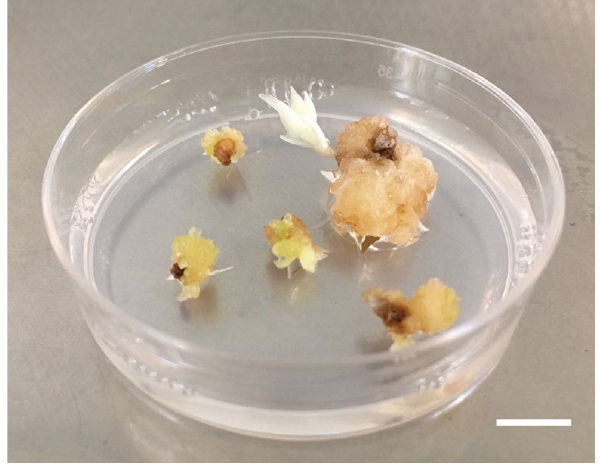
Figure 4. Somatic embryos appeared after 4 months of culture. Somatic embryo (S-CNR-103) generated from Ov explant-derived callus (bar = 1 mm). Table 3. Genotype specificity of the embryogenic response in different Sansevieria genotypes. Percentages of embryogenic explants of seven Sansevieria varieties. Data were collected 6 months after the beginning of the experiment; each treatment comprises 1200 explants. Means ± SE, values followed by the same letter are not significantly different at p ≤ 0.05 level (Tukey’s test).